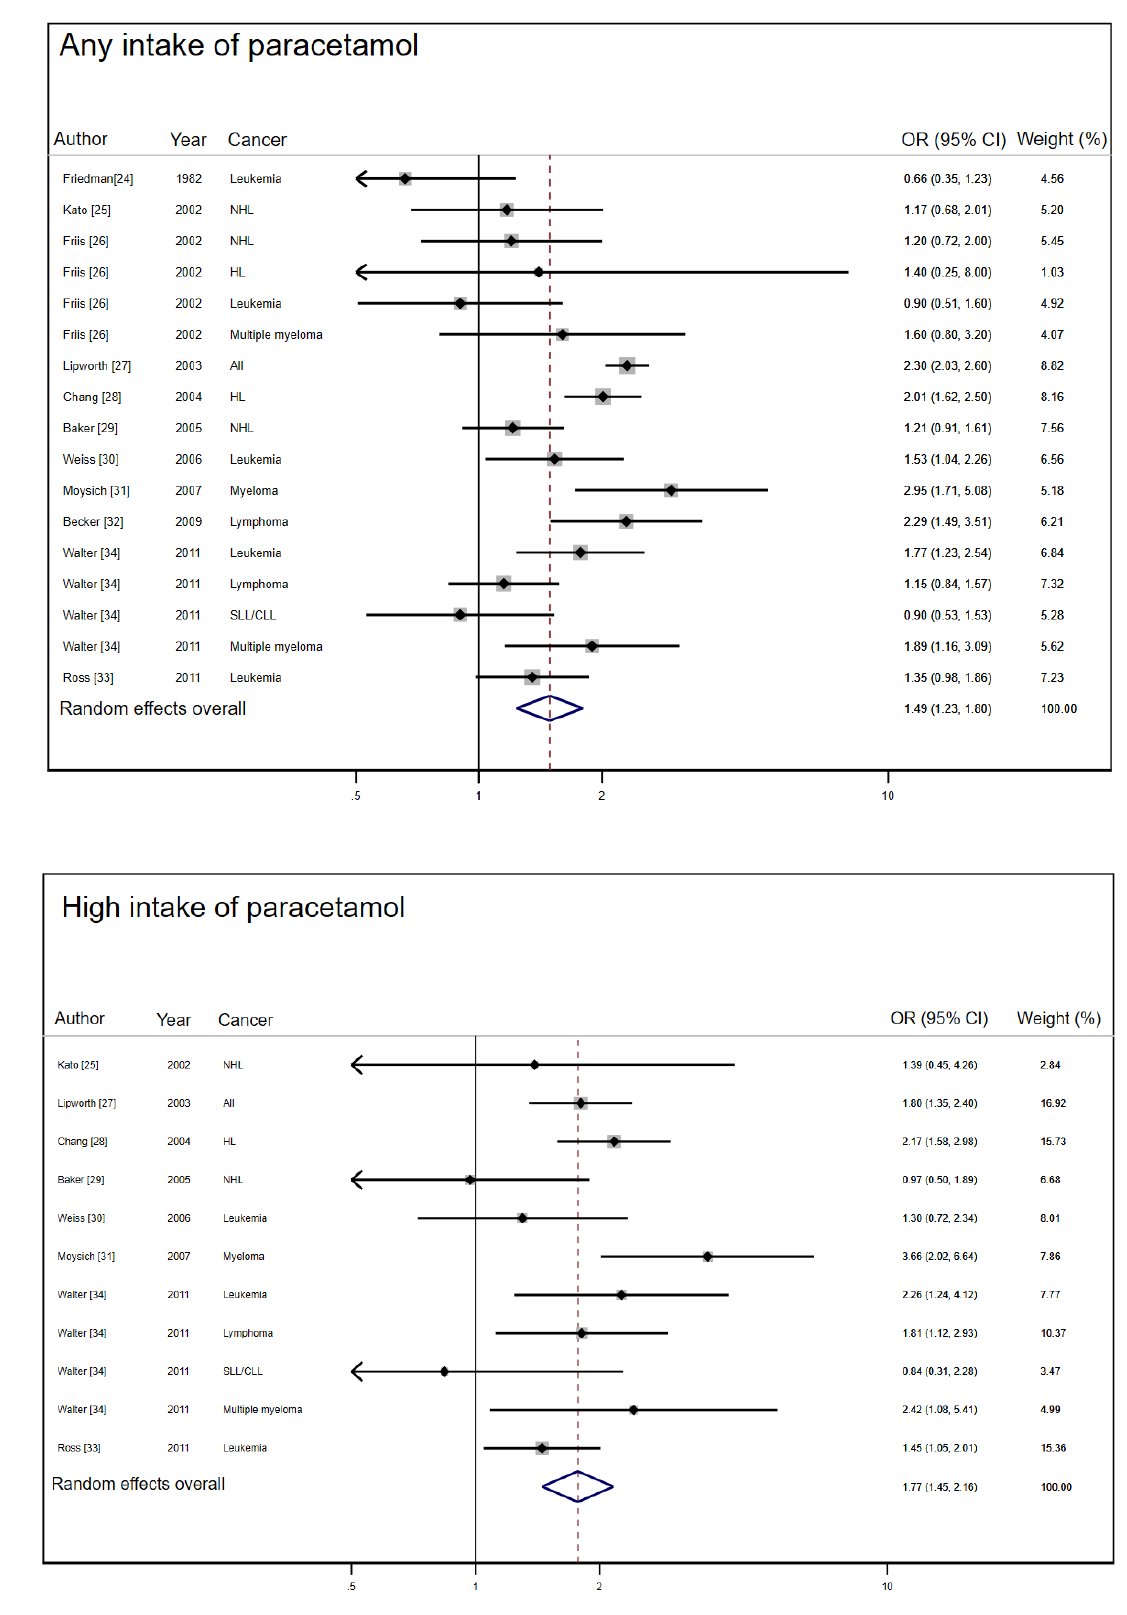
Figure 2. Forest plots of studies included in the meta-analysis of paracetamol intake and hemato- logic malignancies.